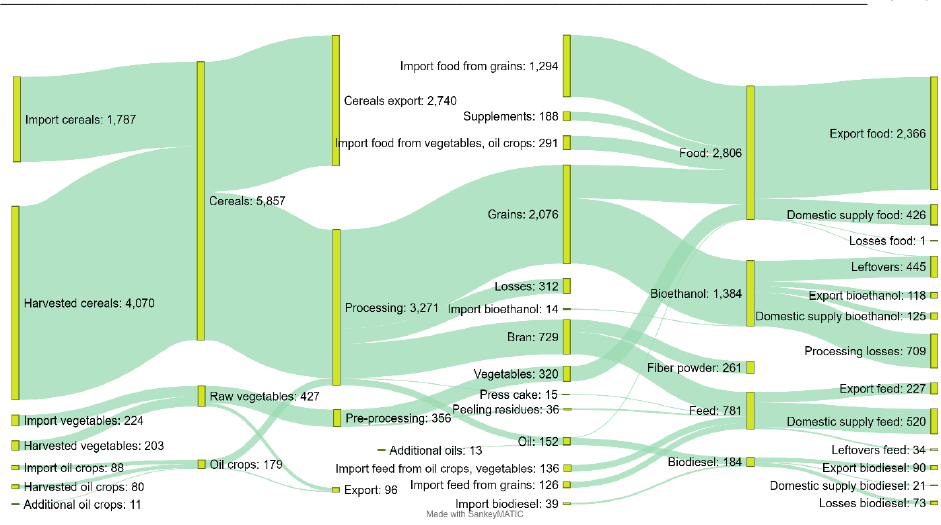
Fig. 9. Best alternative scenario modelling bioresource flow for 2030 crop farming sector, thousand